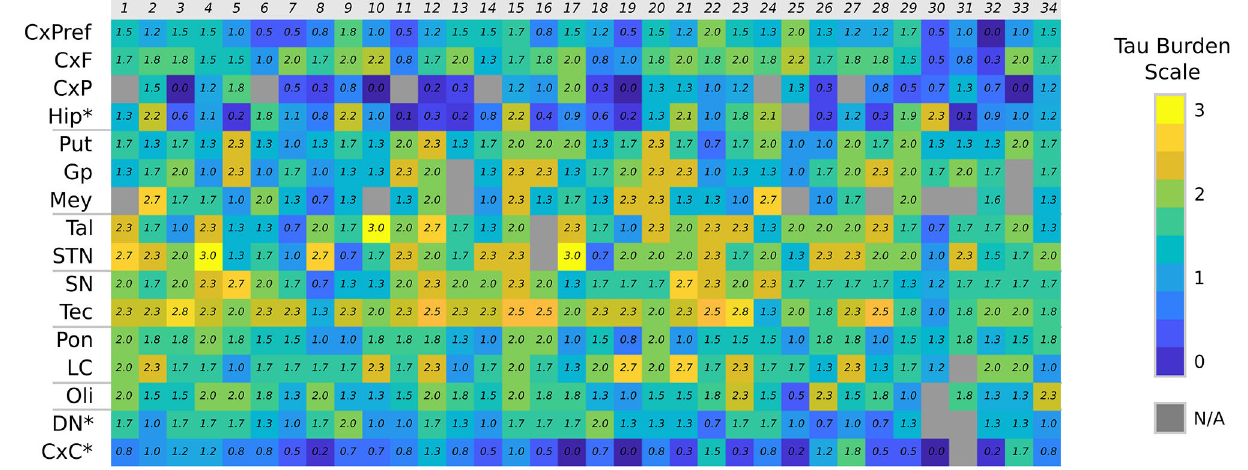
FIGURE 2 | Tau burden heat map. Color chart representing the semiquantitative tau burden score of each anatomical region (CxF, primary motor cortex; CxPreF, middle frontal cortex; CxF, parietal cortex; Hip, Hippocampus; Put, putamen; Gp, globus pallidus; Mey, basal nucleus of Meynert; Tal, medial thalamus; STN, subthalamic nucleus; SN, substantia nigra; Tec, midbrain tectum; Pon, ventral part of the pons; LC, locus coeruleus; Oli, olive nucleus; DN, dentate nucleus; CxC, cerebellar cortex). N/A, not available. *Not included in the